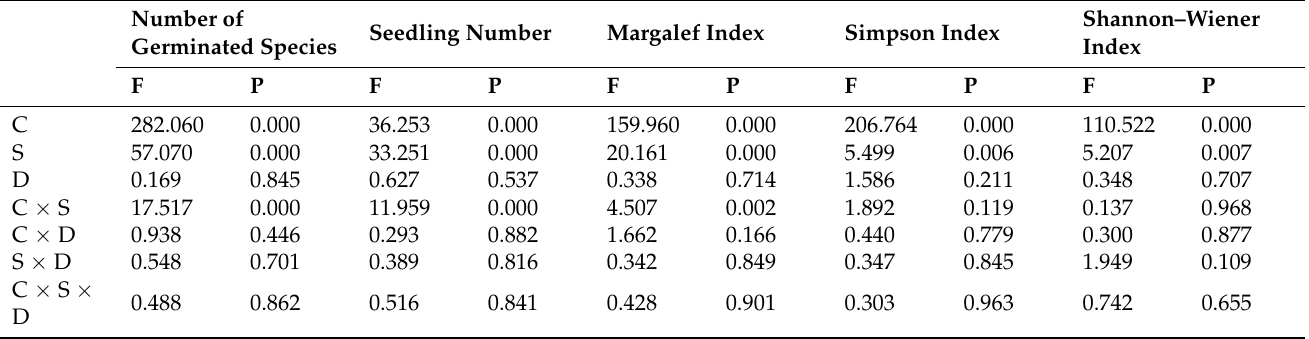
Table 5. Three-way ANOVA analysis of vegetation community types, salinity, and diesel concentra- tion on the germination and diversity of soil seed banks in the YRD.